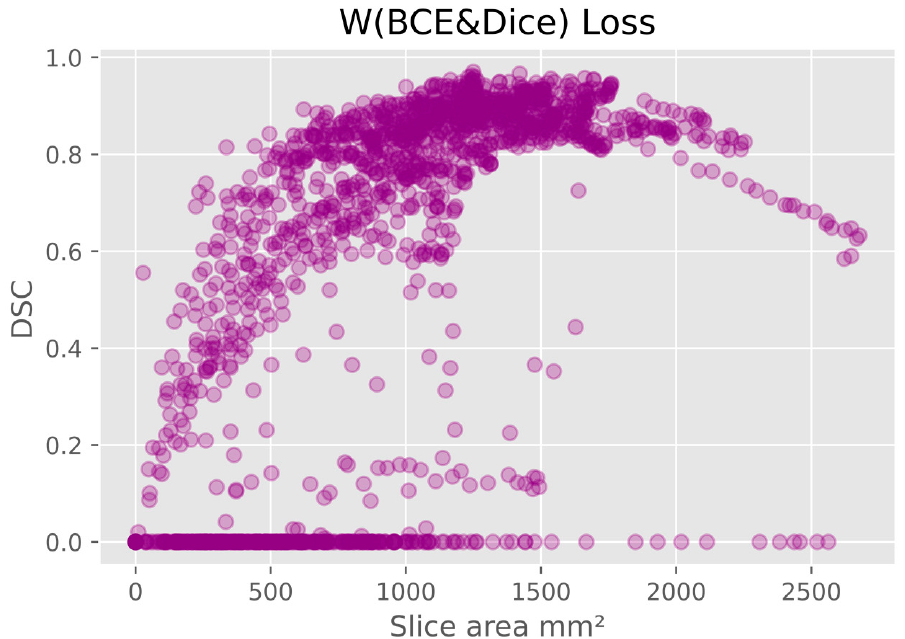
Figure 5. Dice score as a function of prostate area A reverse U shape is observed, indicating the prediction at the mid-gland (500–2000 mm 2 ) outperformed those at the base (>2000 mm 2 ) and apex (<500 mm 2 ). The zeros at the bottom correspond to cases where the model totally missed the prostate region (Dice score = 0). Data is based on the prediction from the model using W (BCE + Dice) on the validation data. The same pattern is seen in all models. W (BCE + Dice): weighted binary cross-entropy with Dice.